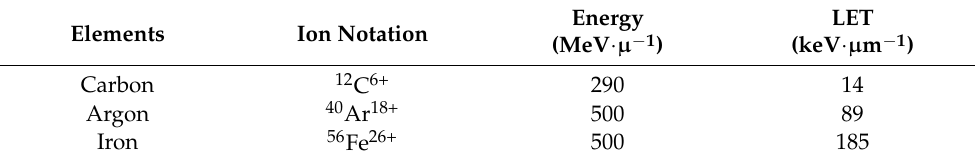
Table 3. Outline of ion beam irradiation.